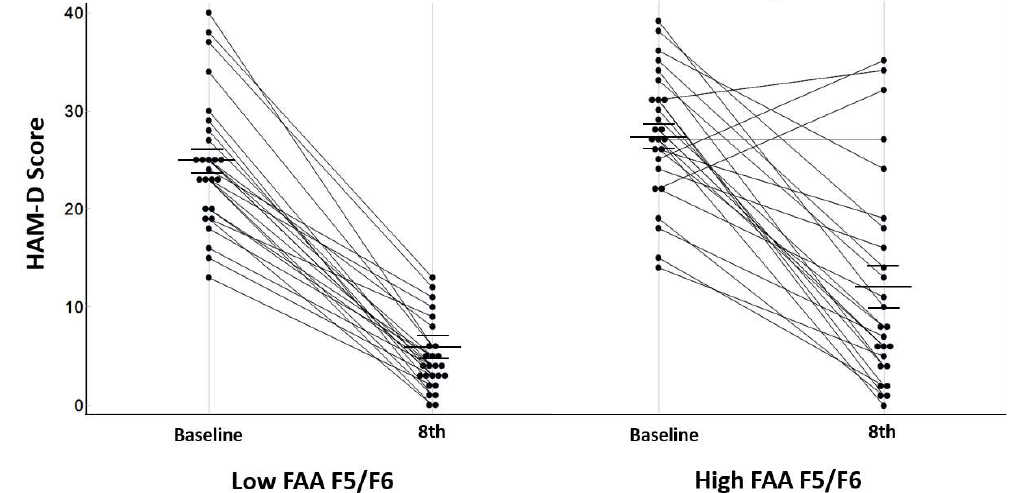
Figure 5. Parallel Coordinates of change in HAM-D scores from baseline to 8th week of treatment benchmark by Low and High FAA F5/F6 groups. Trend in Low FAA F5/F6 group is uniformly downward, whereas the trend in High FAA F5/F6 group is dispersed.